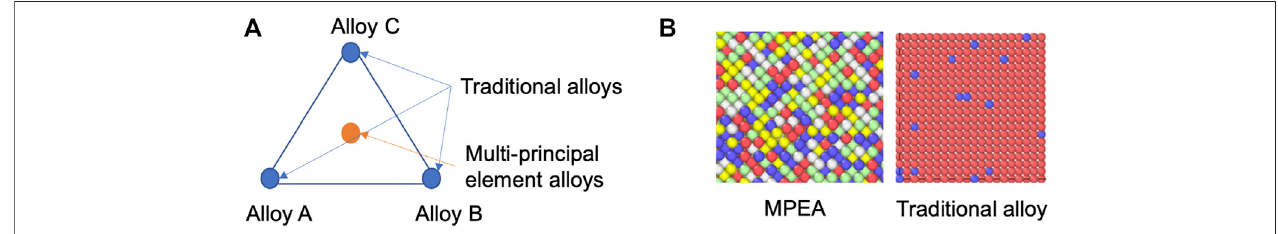
FIGURE1| Comparingdilute(conventional)andconcentrated(MPEA)solidsolutions: (A) Inaternaryphasediagramconventionalalloysareconstrainedtocorners of the compositional space, whereas MPEAs occupy regions near the center of the phase diagram. (B) Random segregation of various elements can occur in MPEAs pertaining to a single phase solid-solution, while a sparse distribution of minor proportions of alloying elements is noted in conventional